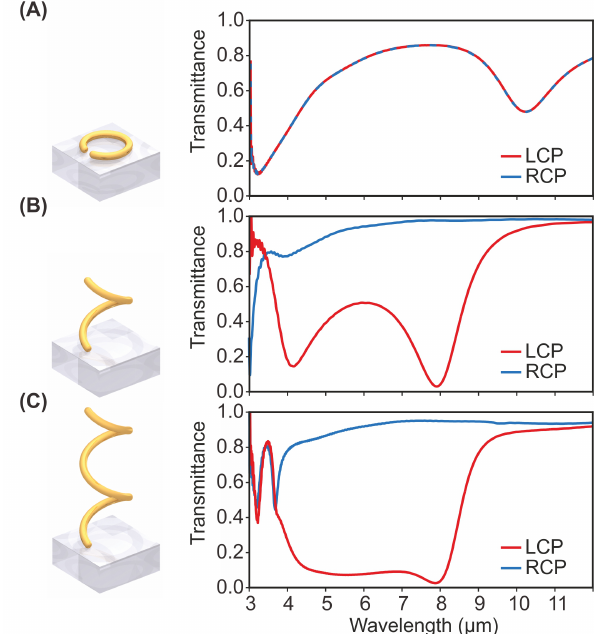
Figure 1: The three panels show the circular polarization normal- incidence transmittance spectra for the three different cases of an achiral split-ring resonator (A), a helix with one pitch (B), and a helix with two pitches as indicated on the left (C). For the achiral case in (A), transmittance for RCP and LCP is equal. Two distinct resonances with strong circular dichroism appears for a helix with one pitch, compared to the broad operation band for a helix with two pitches (C) (adapted with permission from [18]. Copyright 2009 American Association for the Advancement of